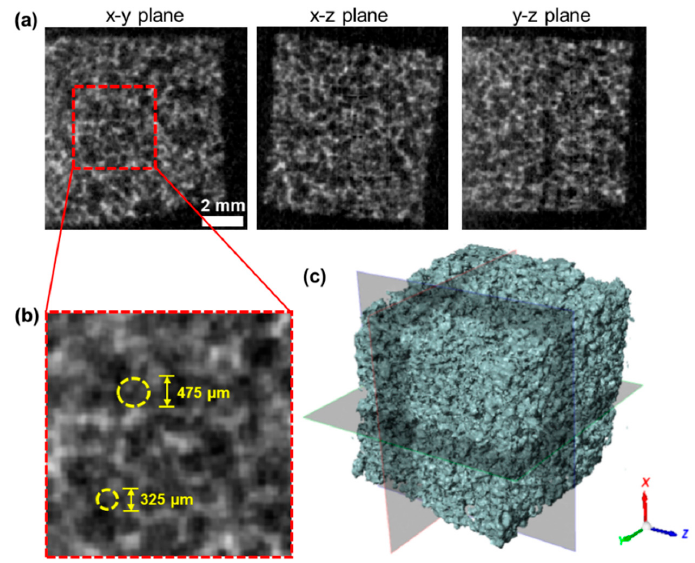
Figure A1. Micro-CT images showing the microstructure of SMP foam: ( a ) 2D image slices on orthogonal planes, ( b ) zoom-in area of the 2D image slice on the x-y plane, demonstrating the typical pore sizes of the SMP foam, and ( c ) the visualization of the reconstructed 3D geometry of the cubic SMP foam (10 mm by 10 mm by 10 mm).